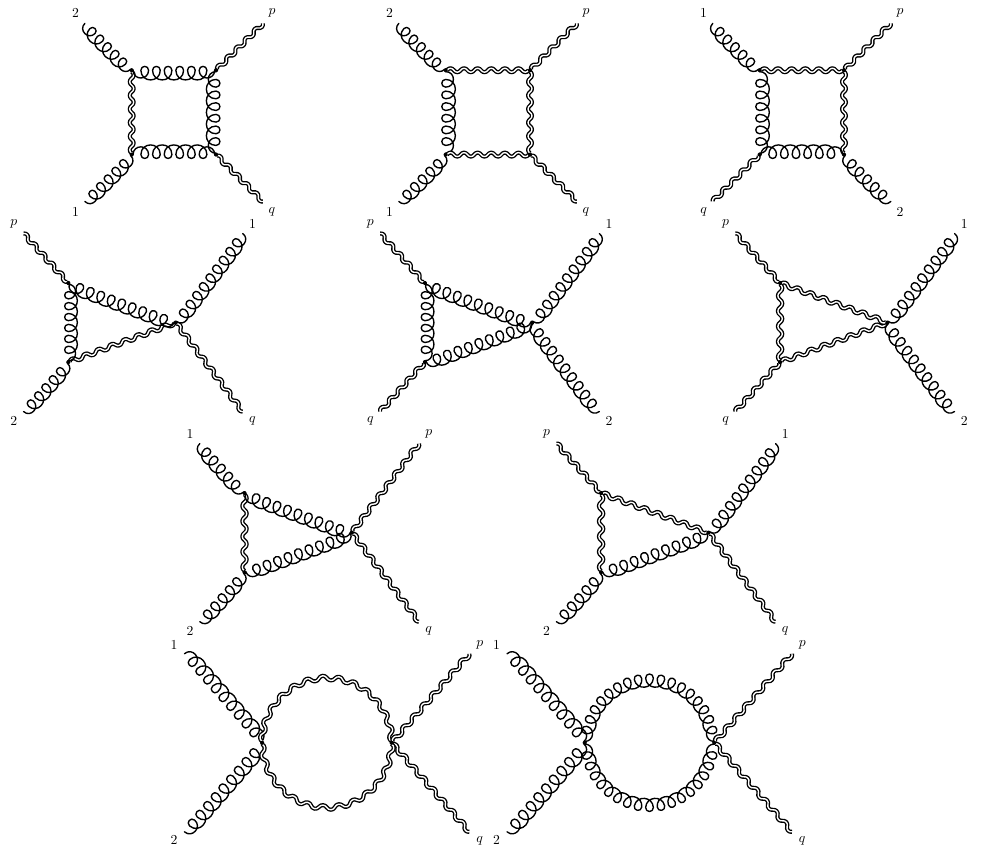
Figure 17 . At the κ 4 order of the two-gluon and two-graviton amplitude of EYM, various boxes, triangles and bubbles contribute to the integrand